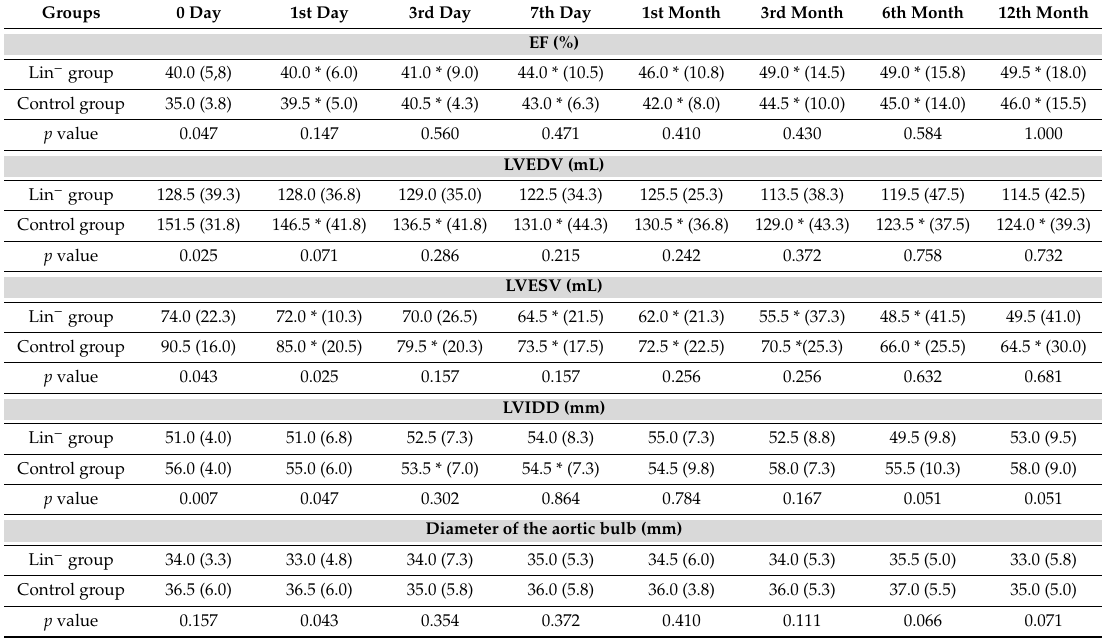
Table 3. The selected ultrasonographic parameters in the Lin − group and in the control group (day 0, 1, 3, and 7 and in month 1, 3, 6, and